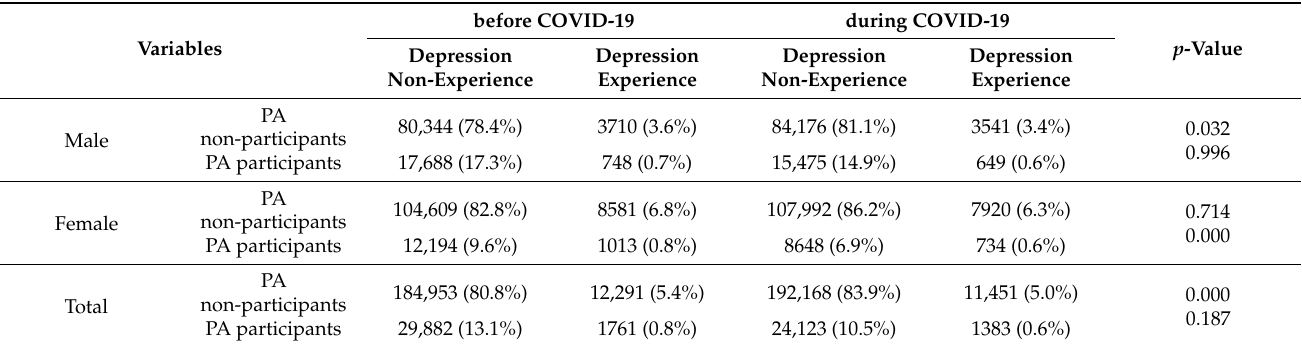
Table 3. Changes in depression by gender and regular PA before and during